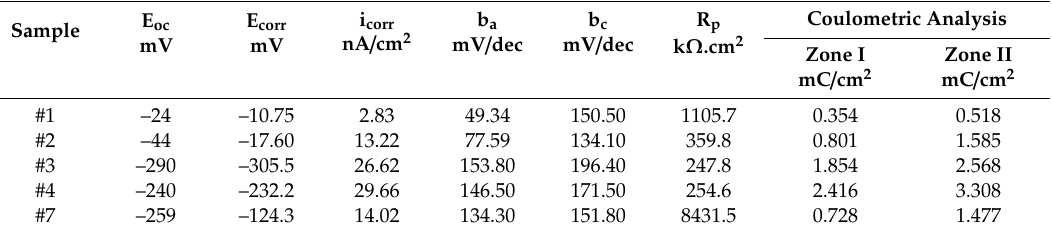
Table 5. Electrochemical parameters determined for Ti-based alloys in 9 g / L